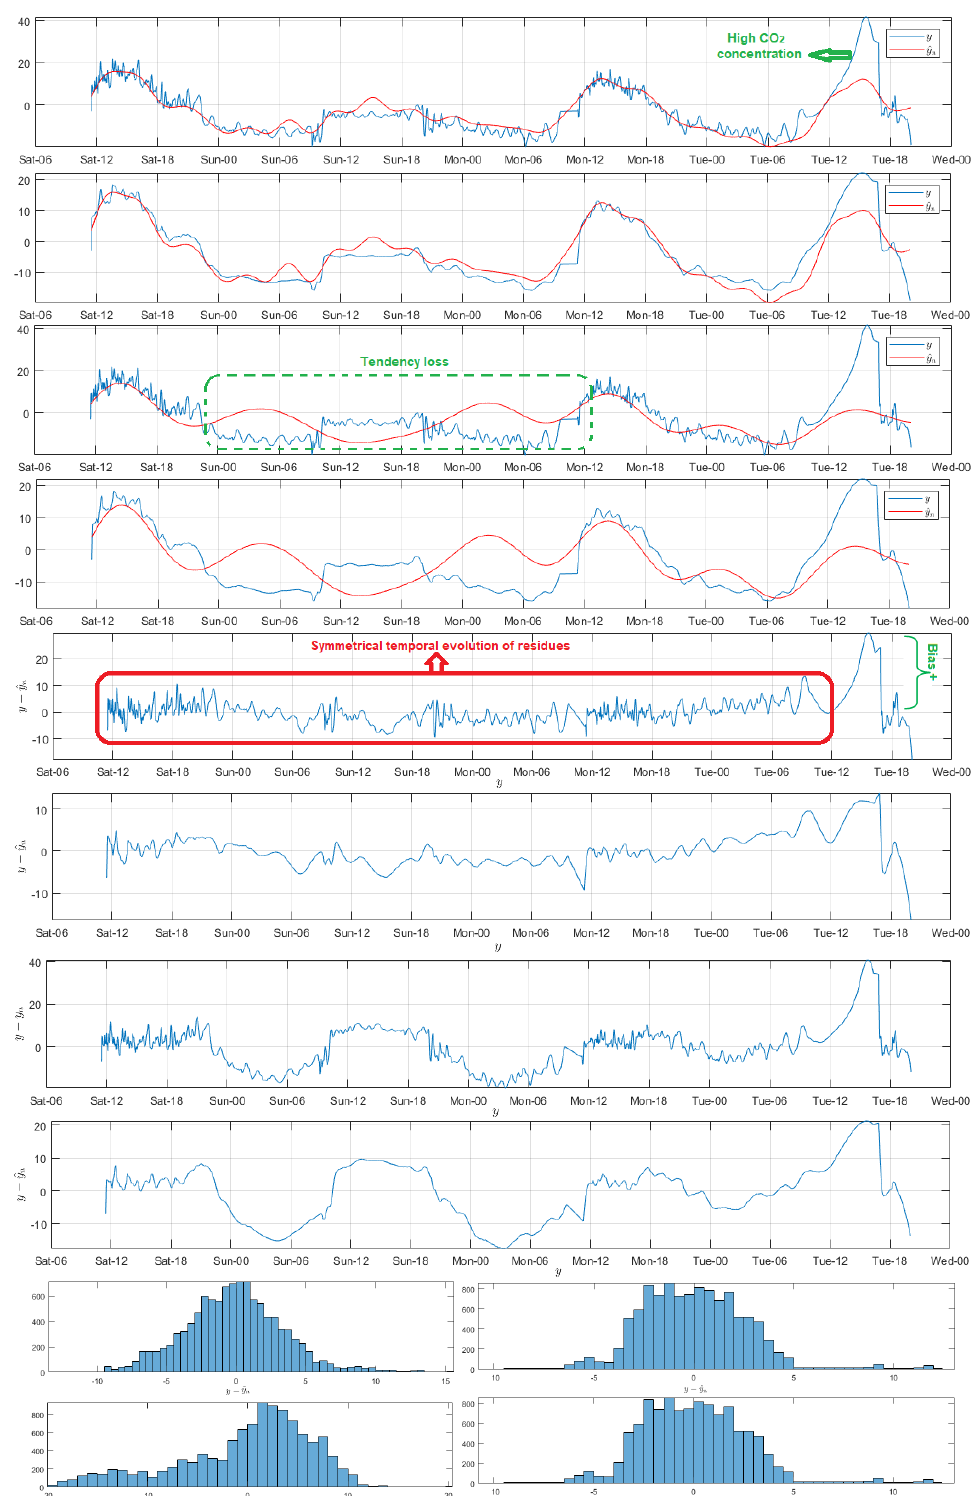
Figure A3. Modeling of CO 2 signal from Sensor Node 4 of DigiMesh network. From top to bottom: Rhythmometric analysis with Reg = 15 and Ord = 30; Reg = 15 and Ord = 100; Reg = 40 and Ord = 30; Reg = 40 and Ord = 100; Residual time evolution with Reg = 15 and Ord = 30; Reg = 15 and Ord = 100; Reg = 40 and Ord = 30; and Reg = 40 and Ord = 100; Histograms with Reg = 15 and Ord = 30 ( left ); and Reg = 15 and Ord = 100 ( right ); and Histograms with Reg = 40 and Ord = 30 (left); and Reg = 40 and Ord = 100